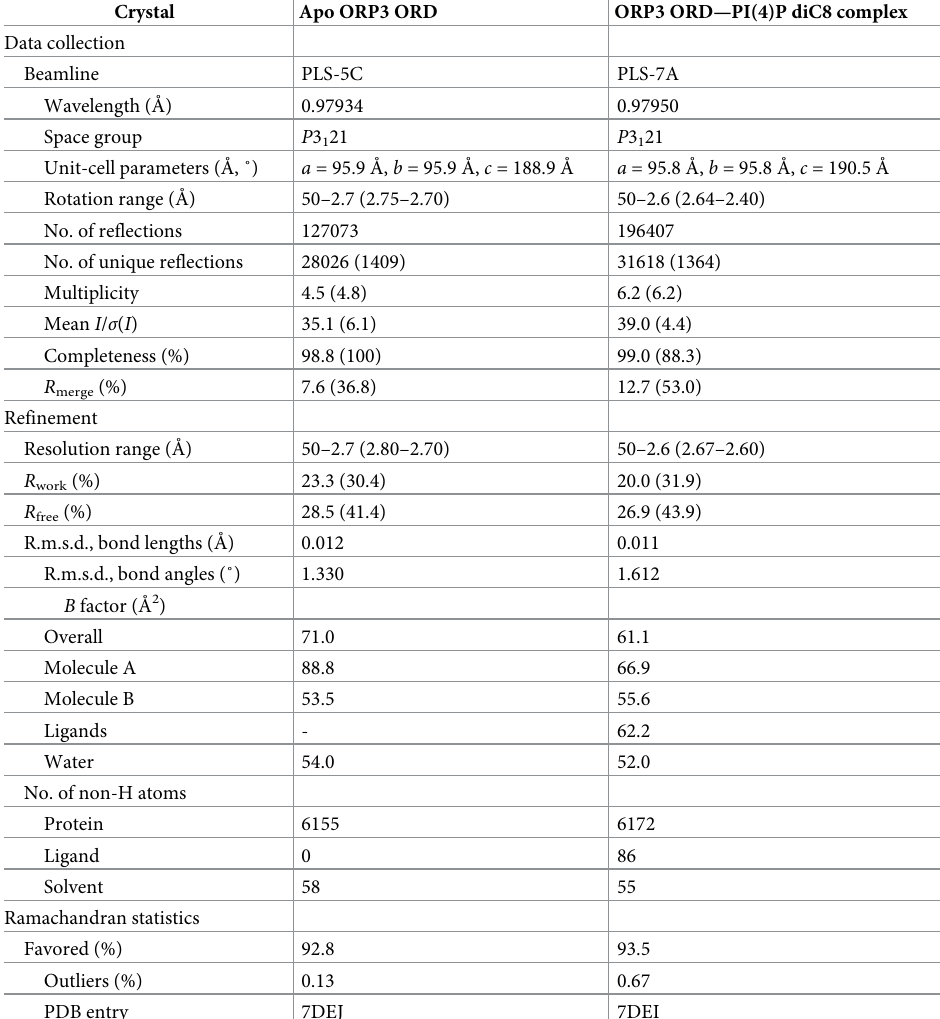
Table 1. Data-collection and refinement